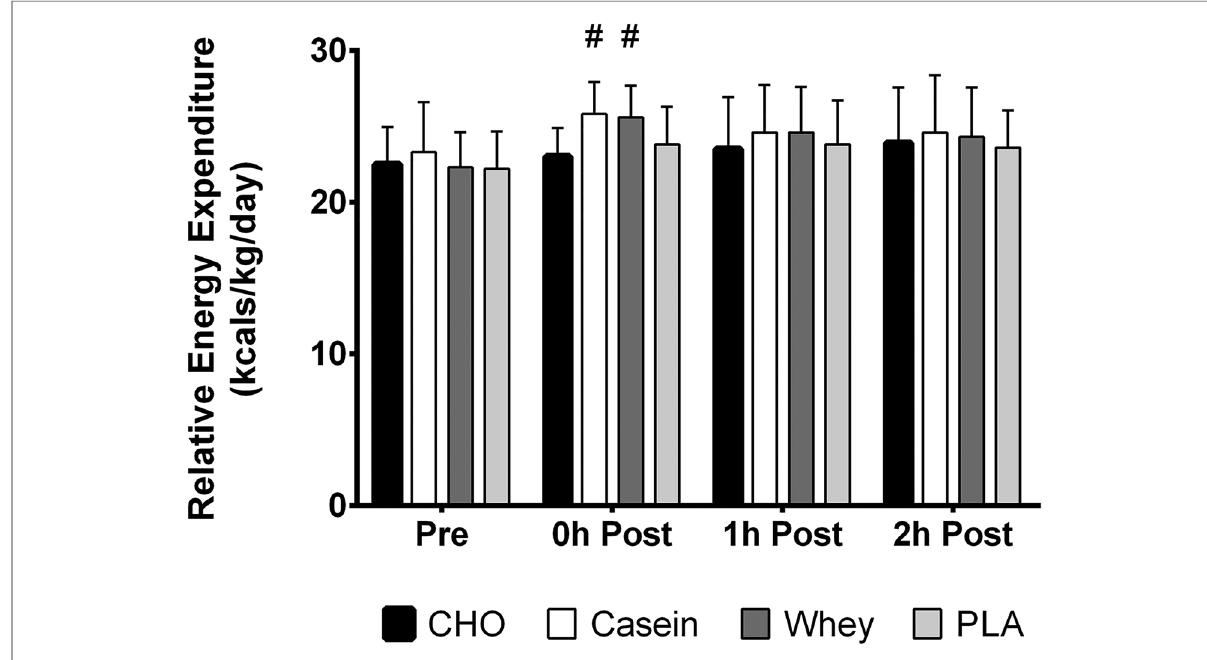
FIGURE 3 REE relative to body weight in kilograms over all four time points in each condition. #, different than CHO ( p